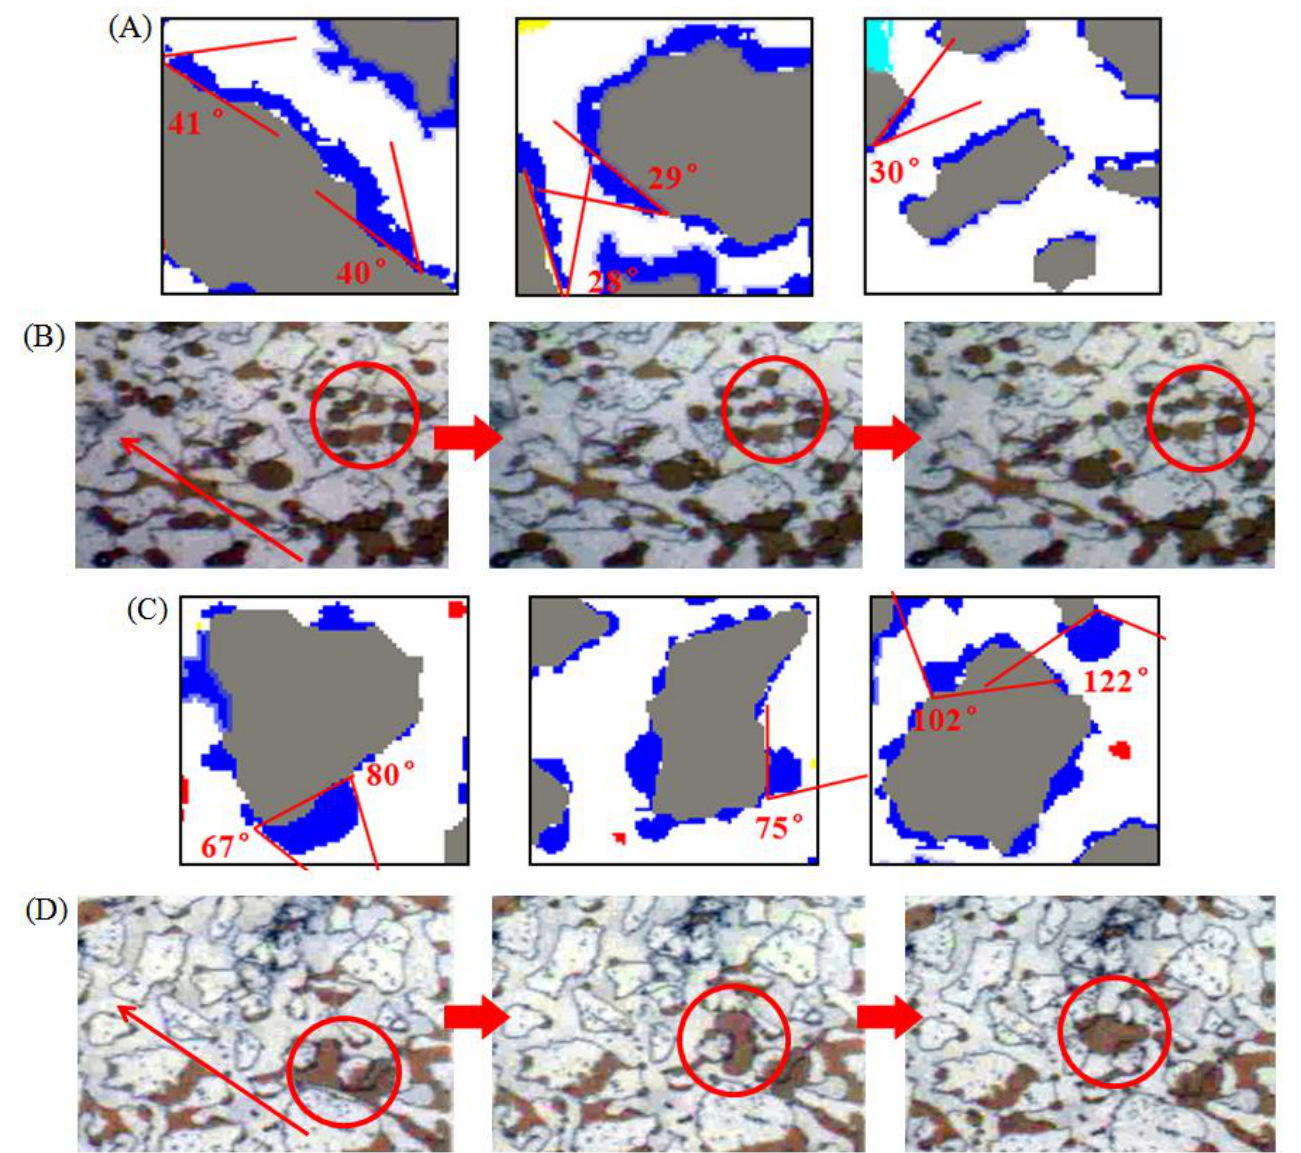
Figure 9. The microscopic three phase contact angles of membranous remaining oil in simulated homogeneous model after ASB ( A ) and A145 ( C ) flooding; The movement of crude oil emulsion in pore throat during ASB ( B ) and A145 ( D ) displacement.